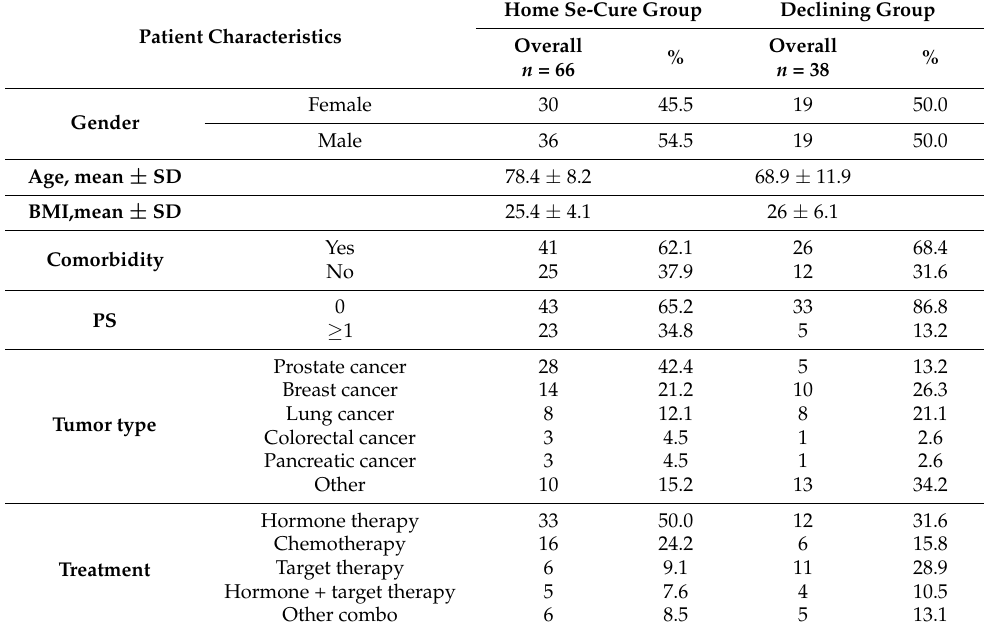
Table 2. Patient characteristics.